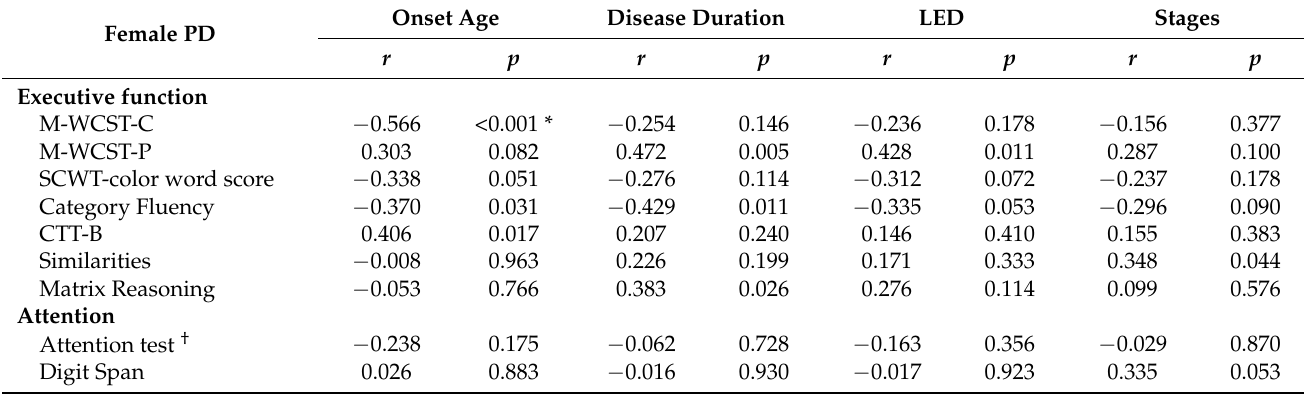
Table 5. Correlations between the clinical characteristics and the neurocognitive performances in female